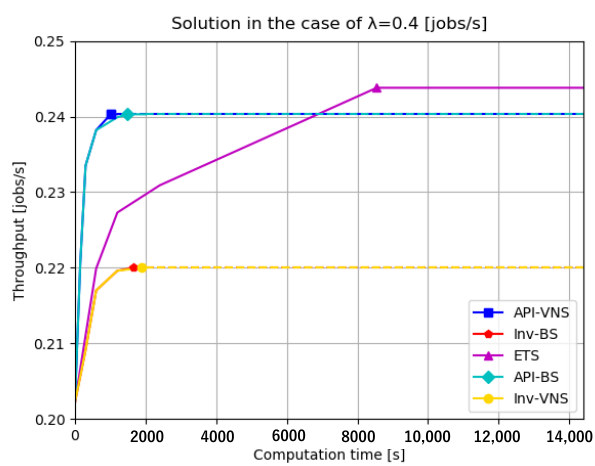
Figure 9. Computation time vs. throughput curves for the five methods in the case of λ = 0.4 in experiment 1.